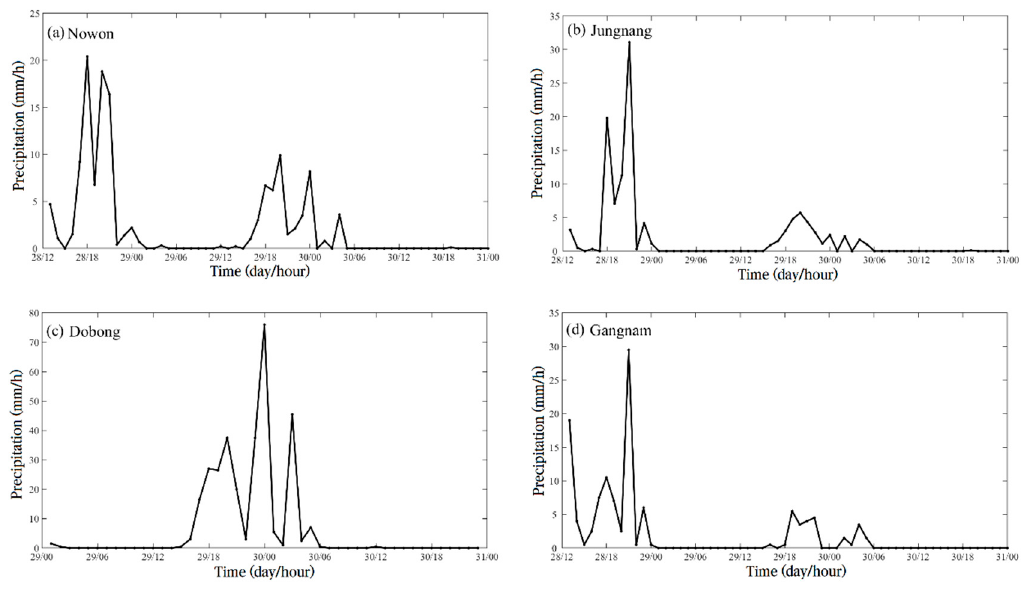
Figure 5. Time series of 1 hour of observed accumulated rainfall at ( a ) Nowon, ( b ) Jungnang, ( c ) Dobong, and ( d ) Gangnam observational sites. Table 4. Rainfall information of four sites used for the validation of Case